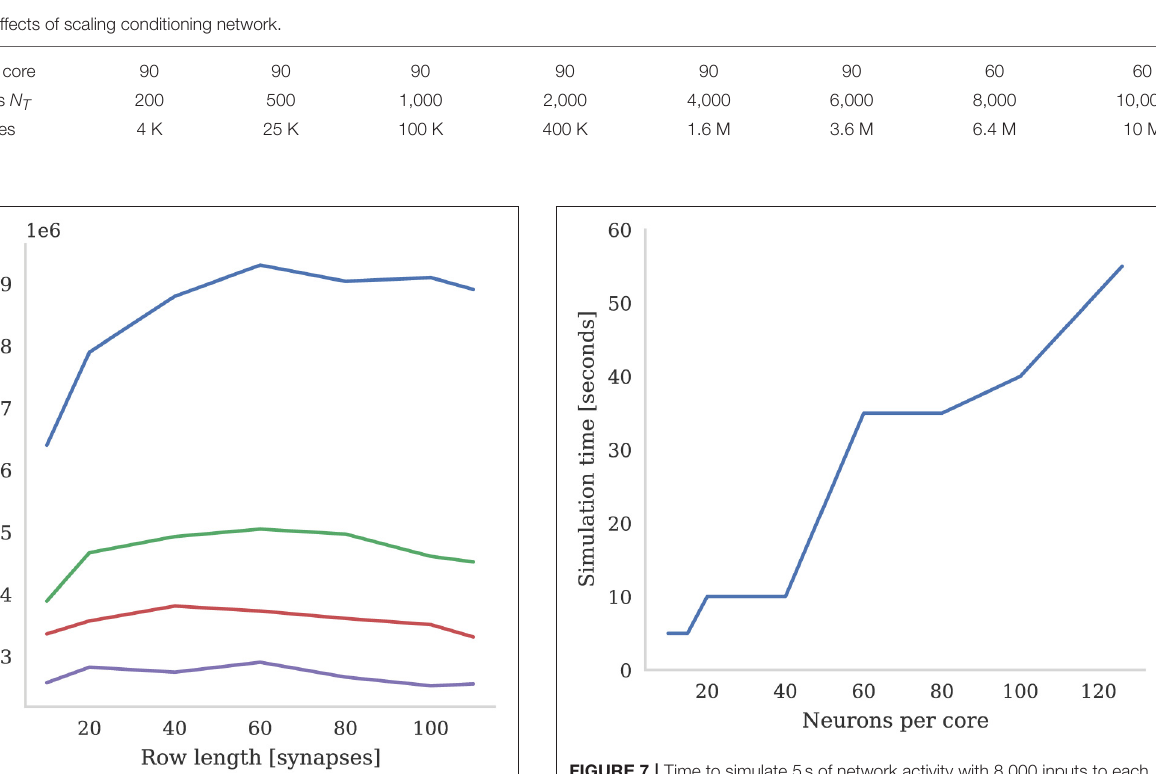
FIGURE 7 | Time to simulate 5s of network activity with 8,000 inputs to each neuron. The mean firing rate of each input is 3Hz, the post synaptic firing rate is 3Hz, and the mean firing rate of the dopaminergic neuron is